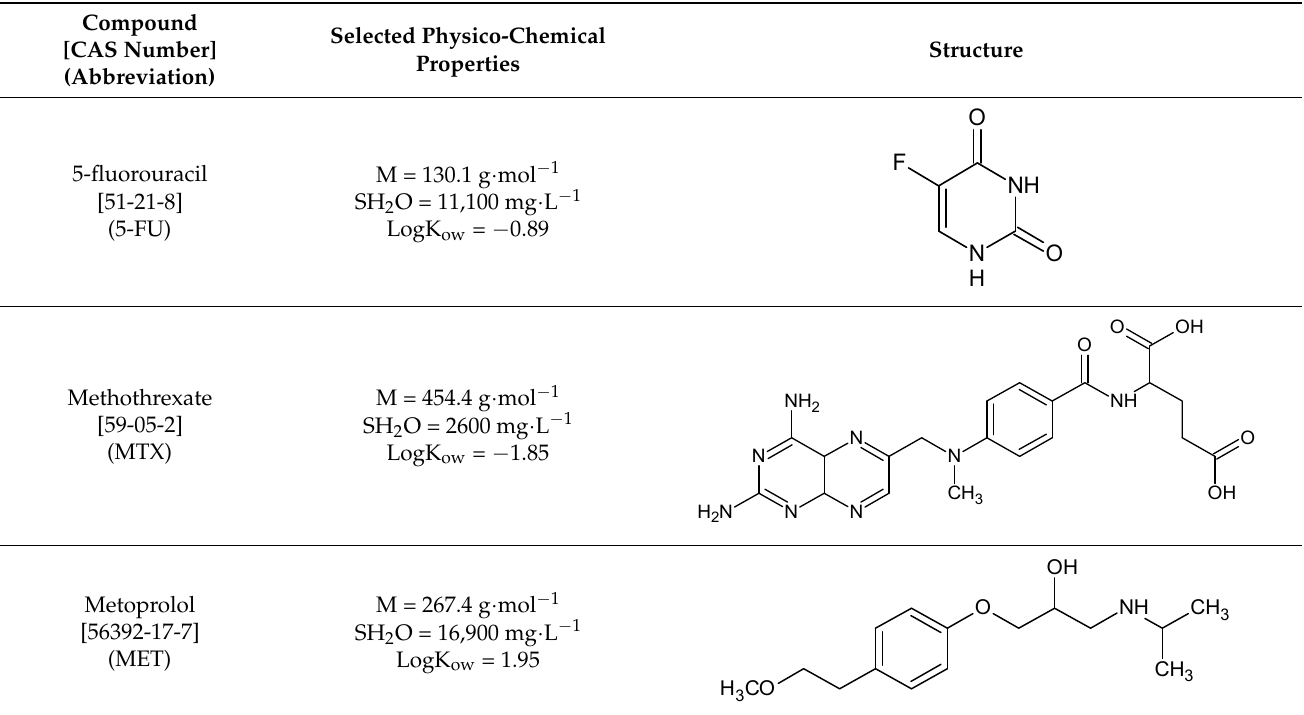
Table 1. Selected physico-chemical properties of the investigated compounds [33,35,36].